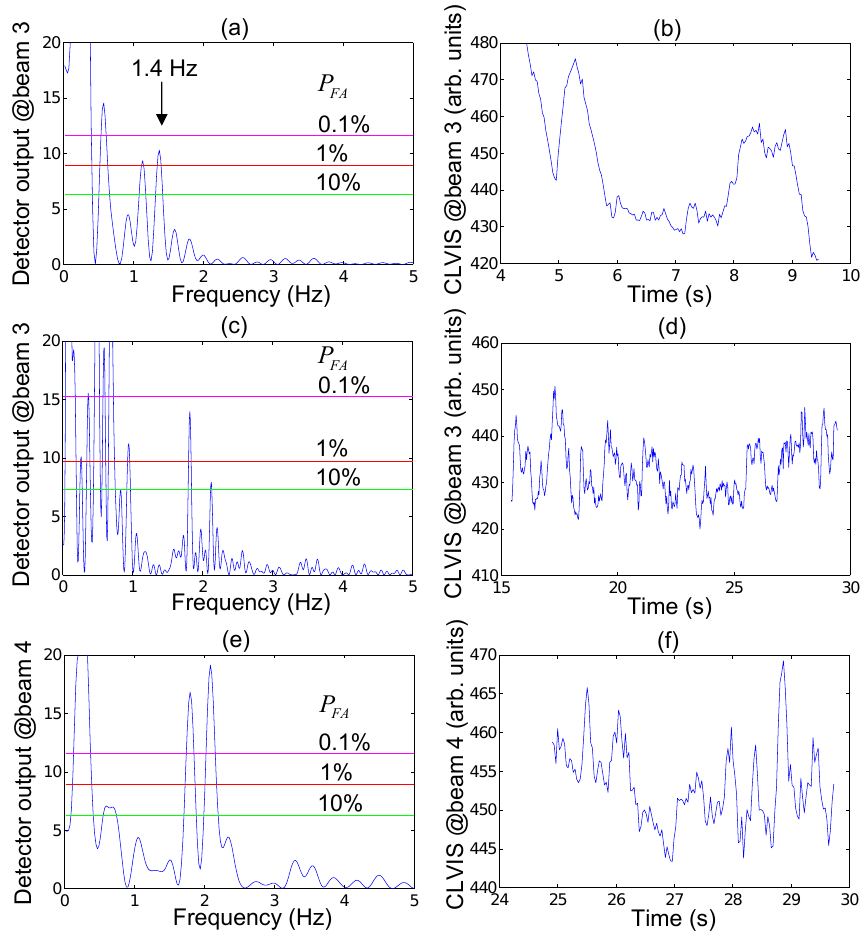
Fig. 7. GLRT detector applied to the CLVIS keogram at the locations of beams 3 and 4. (a) and (b) Detector output and time series at beam 3, for 5s beginning 11:58:06. (c) and (d) Detector output and time series at beam 3, for 14s beginning 11:58:17. (e) and (f) Detector output and time series at beam 4, for 5s beginning 11:58:27. The time axes show the seconds after